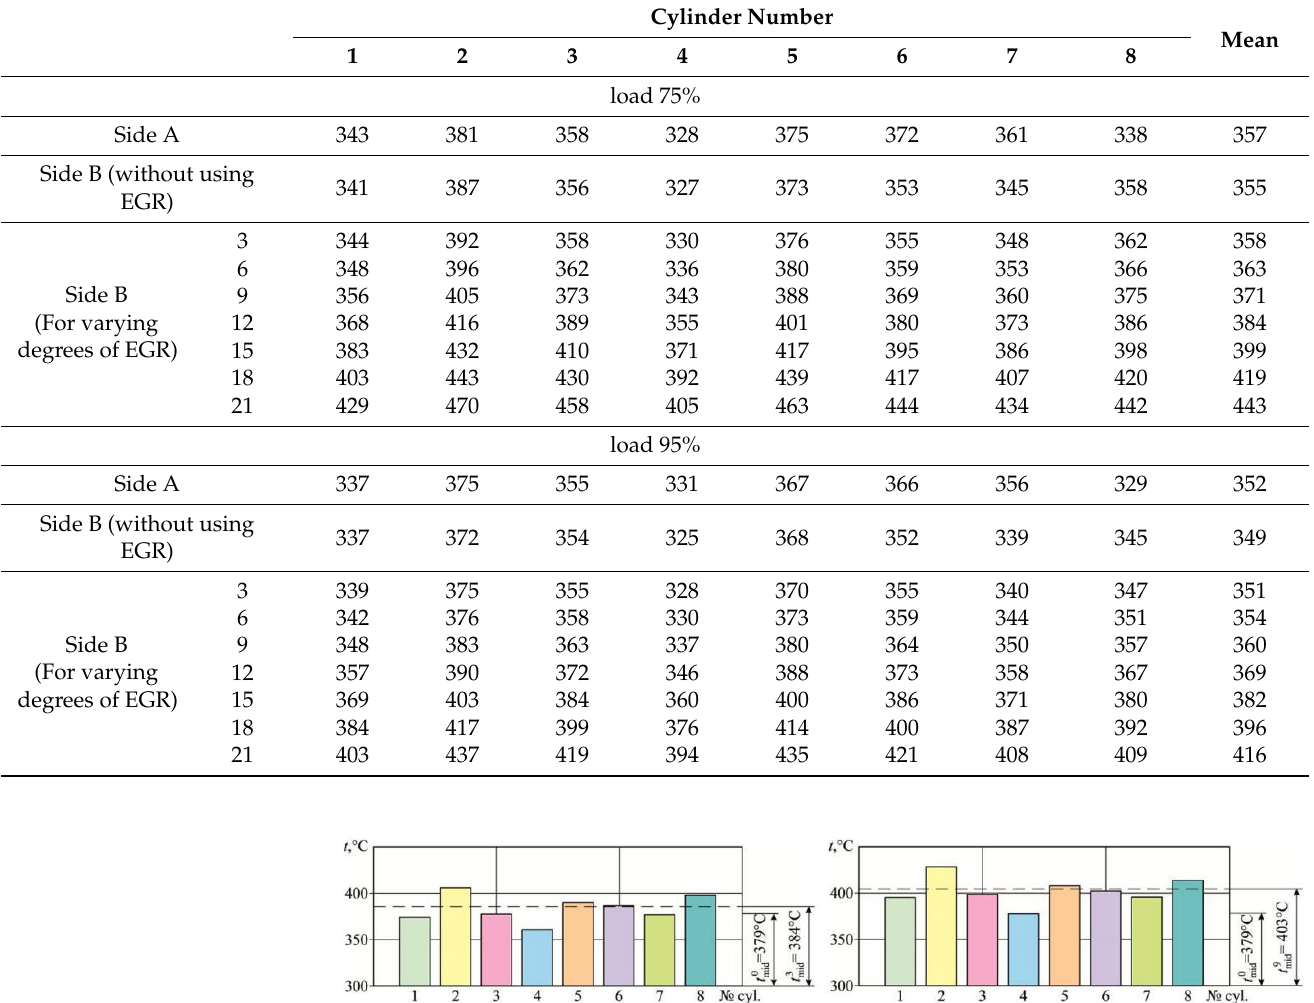
Table 5. Exhaust gas temperature change in the cylinders of a 16V32 STX-MAN marine diesel engine under different experimental conditions (load 75 and 95%).